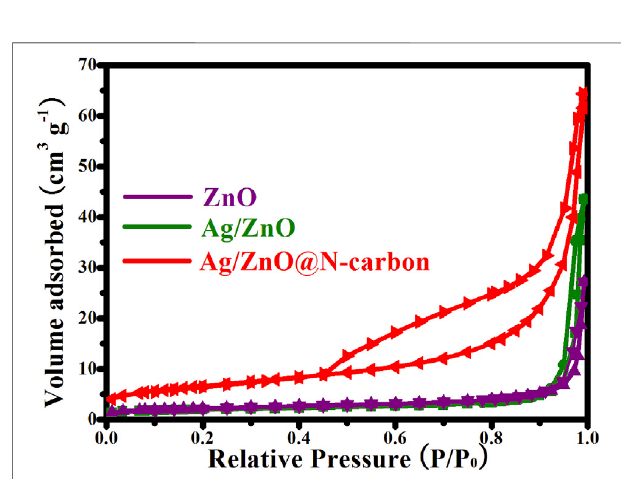
FIGURE 3 | N 2 adsorption-desorption isotherms of ZnO, Ag/ZnO and Ag/ZnO@N-carbon.